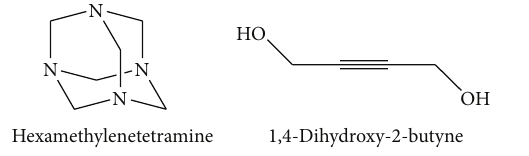
Figure 2: The structure of hexamethylenetetramine and 1,4- dihydroxy-2-butyne.